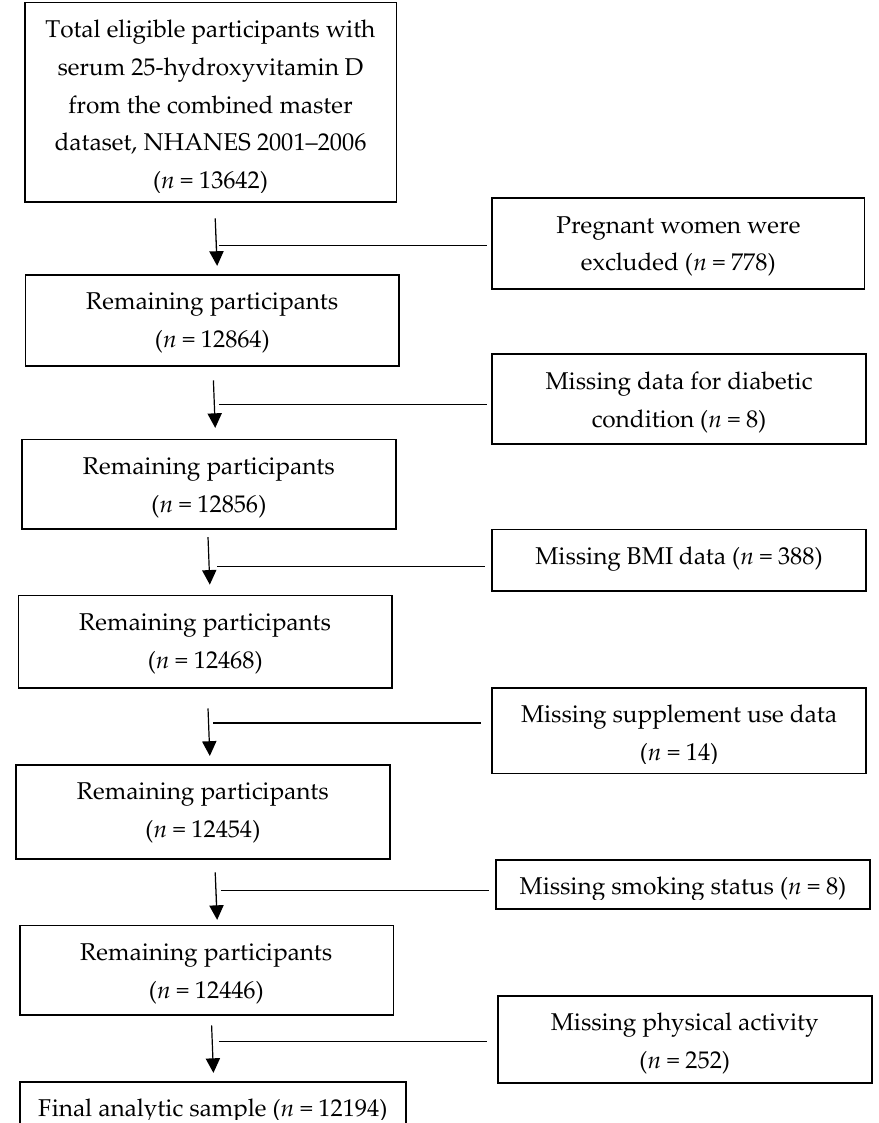
Figure 2. Strengthening of Reporting of Observational Studies in Epidemiology (STROBE) flow chart-sample derivation for the association between serum 25-hydroxyvitamin D concentration and diabetes risk